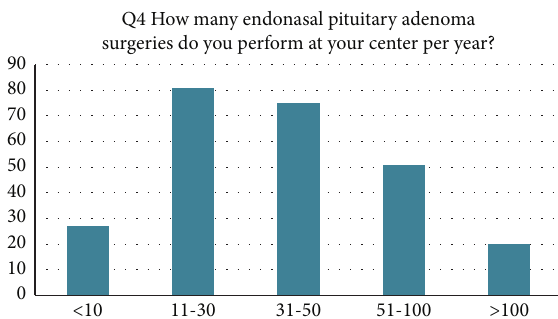
Figure 1: Endonasal surgeries: caseload per year.